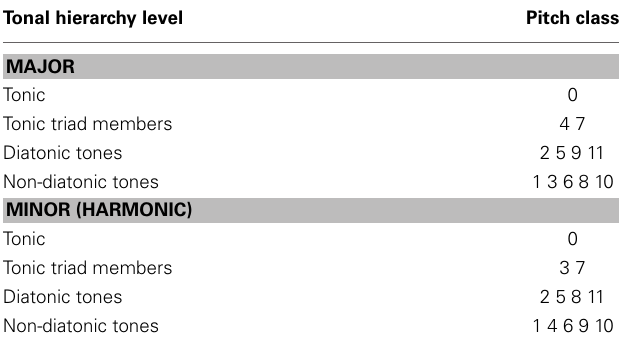
Table 1 | Tonal hierarchies for major and minor